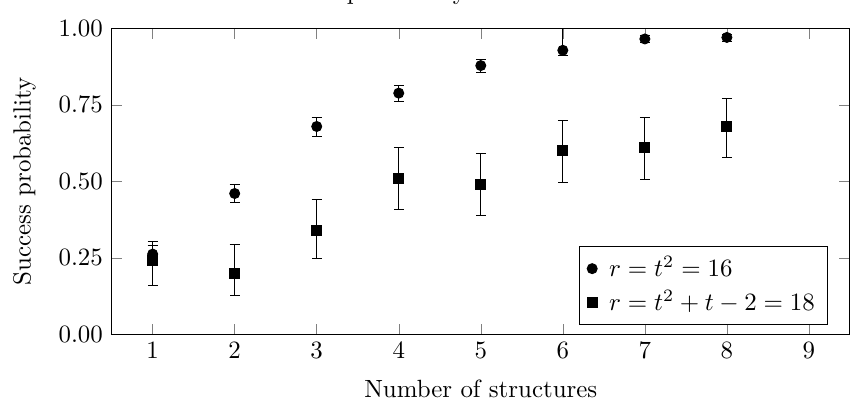
Figure 5: Estimates of the success probability of the distinguishers from Result 3 with t = 4 and τ = 2 ( r = 16) or τ = 3 / 2 ( r = 18) as a function of the data-complexity (number of structures). The error bars correspond to 95% confidence intervals computed using the Clopper-Pearson method. Source code to reproduce this figure is available at https://homes.esat.kuleuven.be/~tbeyne/contracting-feistels.zip